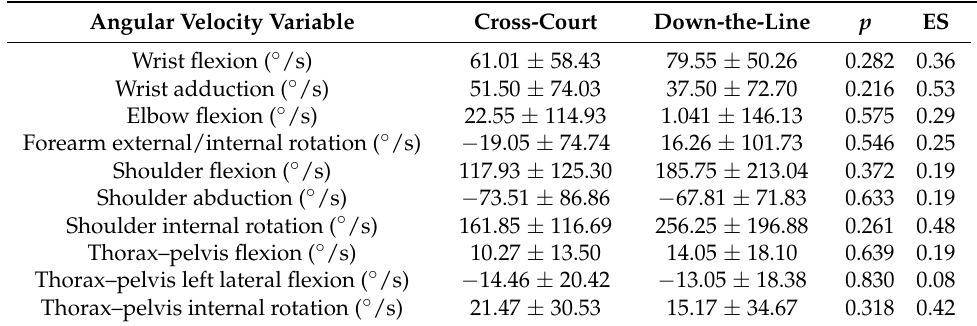
Table 3. The angular velocity biomechanical variables of upper body at the moment of lowest center of gravity ( n = 8).